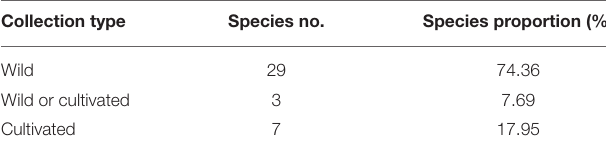
TABLE 3 | Collection type of Baiku Yao veterinary plants. TABLE 4 | Used parts of Baiku Yao veterinary